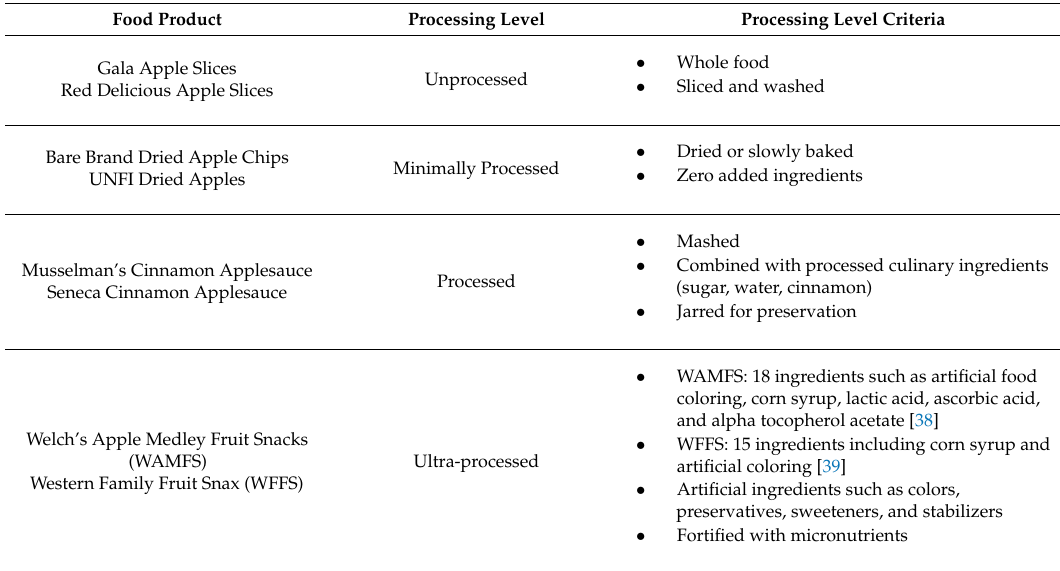
Table 3. Eight apple snack food items used for the research study were randomly assigned to the classrooms so that each classroom received one product from each processing level in a randomized buffet order. Foods were classified into processing levels